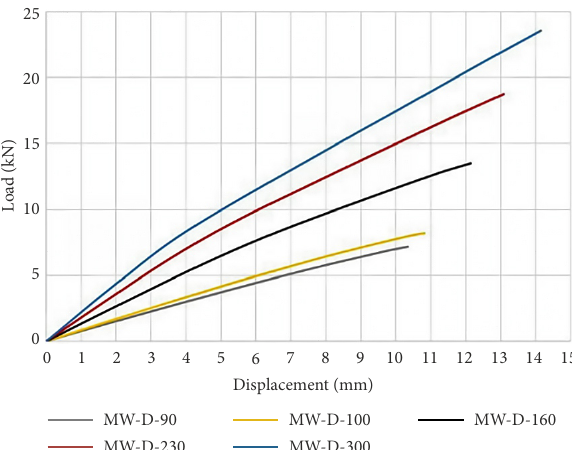
Figure 8. Load-displacement curves for MW panels with different widths